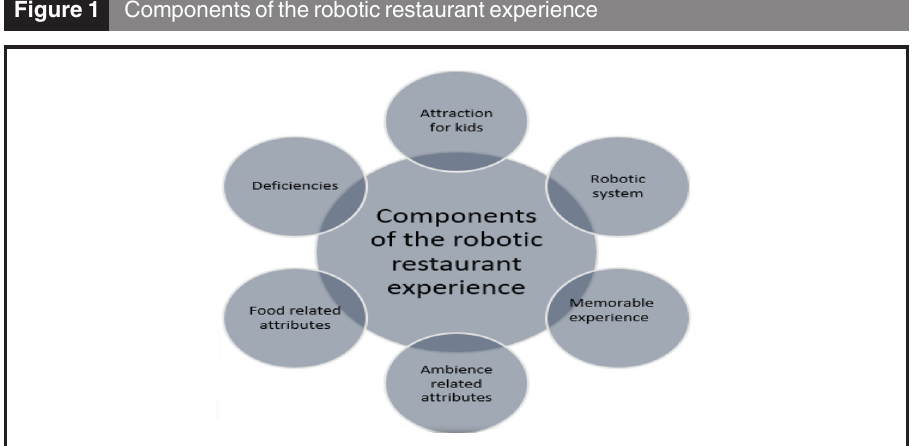
Figure 1 Components of the robotic restaurant